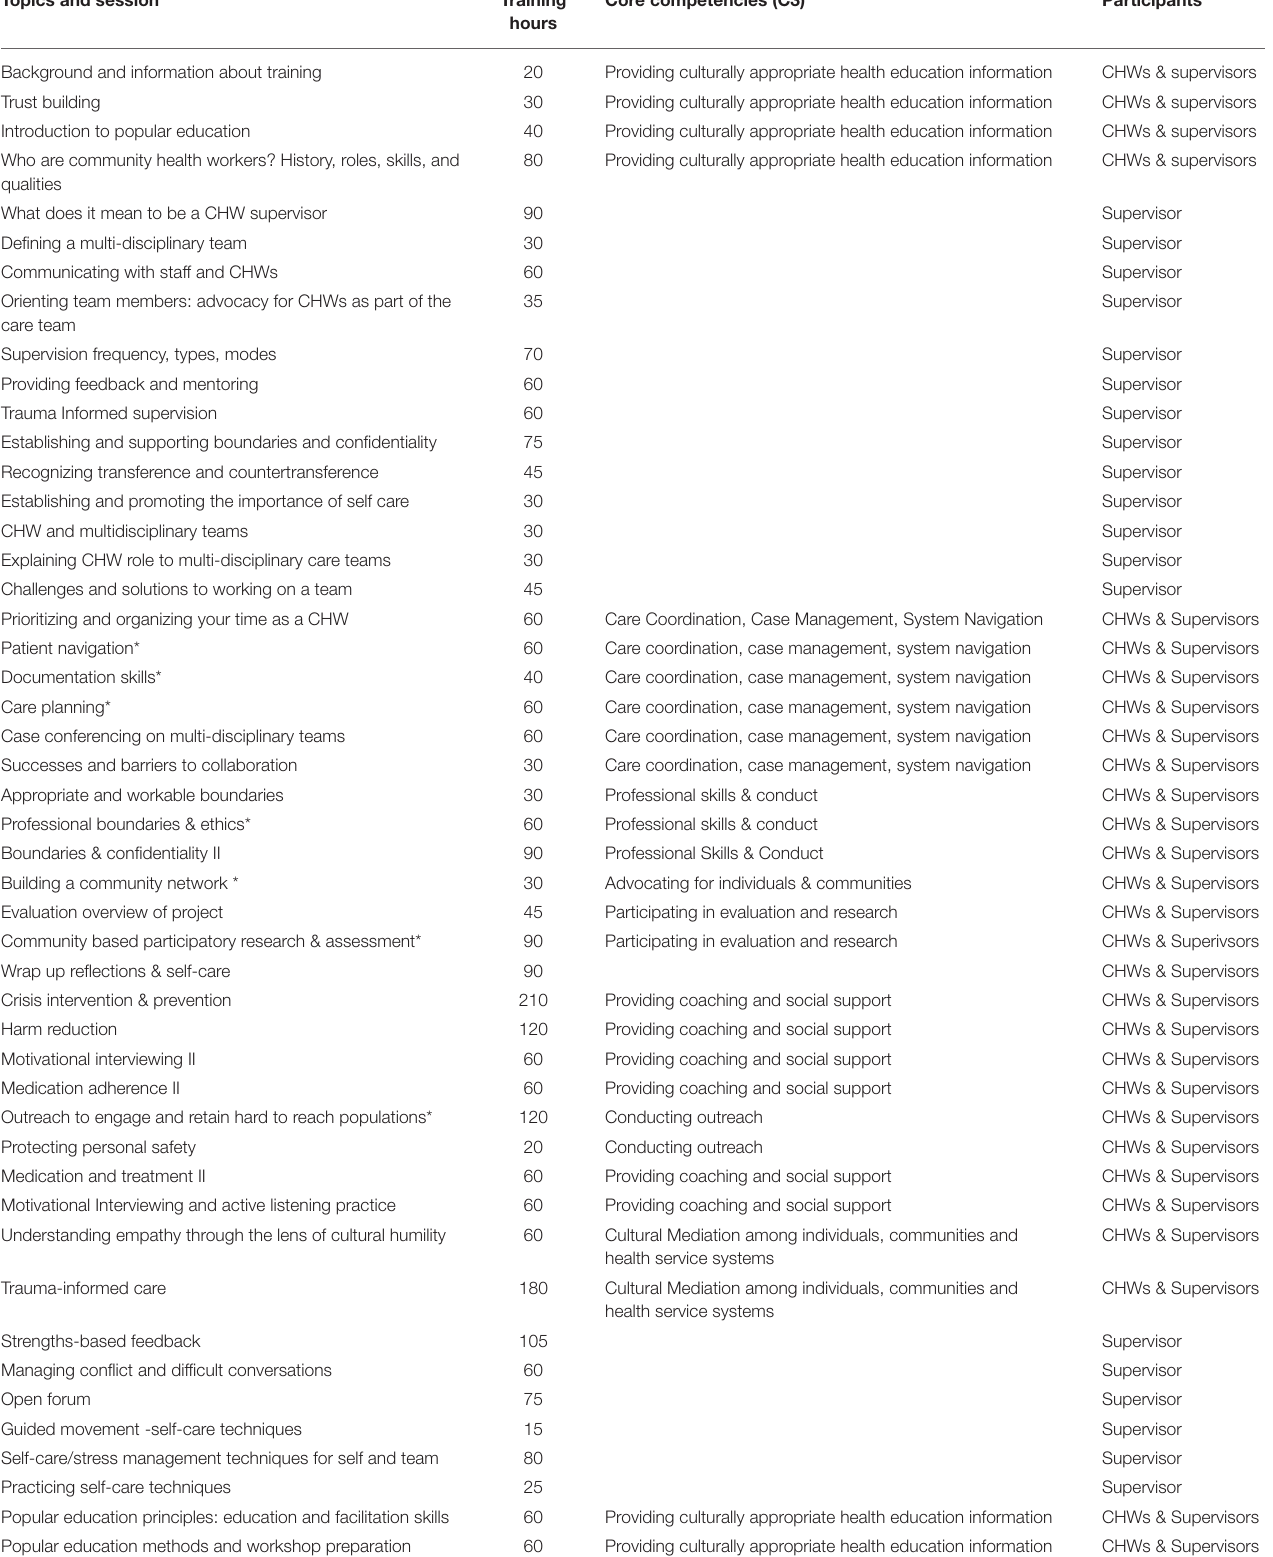
TABLE 2 | CHW core competencies and skills and hours completed by CHWs and supervisors. Topics and